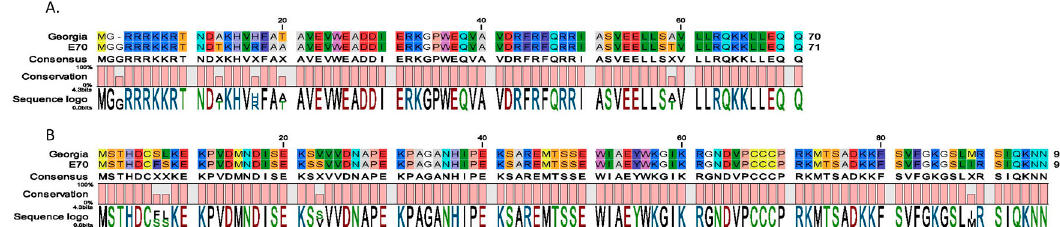
Figure 1. Alignment of the amino acid sequence obtained from full-length African swine fever virus (ASFV) proteins NL (DP71L) ( A ) and UK (DP96R) ( B ) from ASFV E70 and Georgia 2007 isolates.